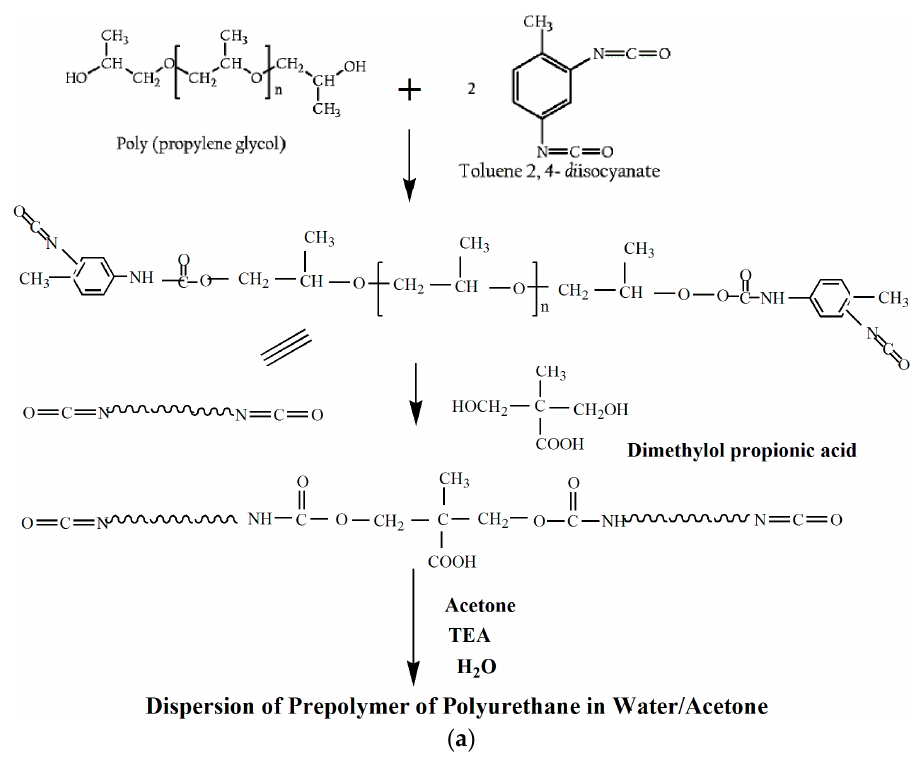
Figure 1. Cont. Figure 1.